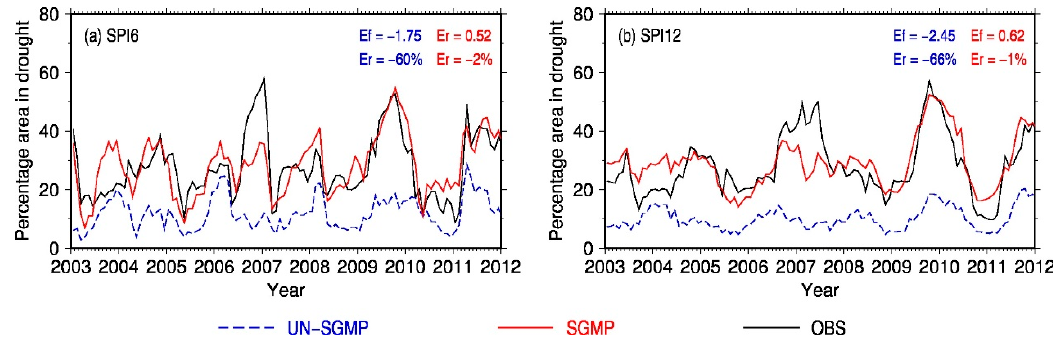
Figure 7. The 10-y percentage area in meteorological drought identified from the ( a ) 6-month SPI (SPI6) and ( b ) 12-month SPI (SPI12) based on the UN-SGMP (blue dash line), SGMP (red line), and OBS (black line) data.